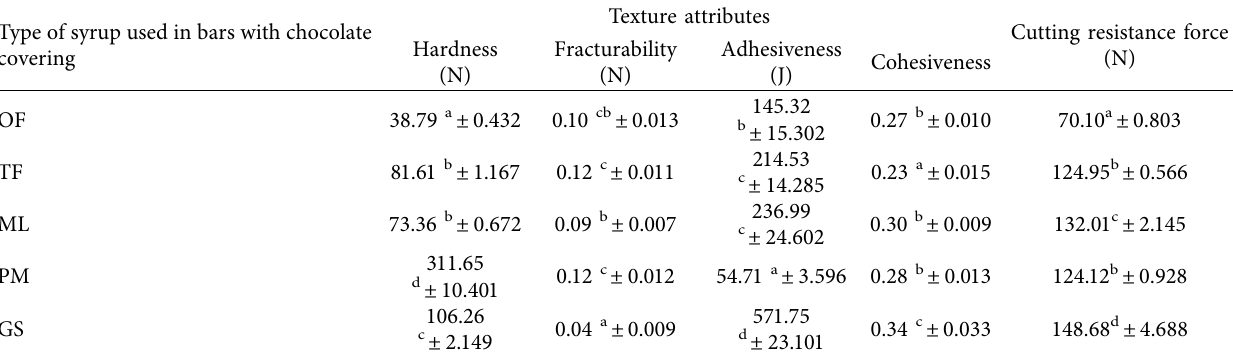
Table 2: Impact of different syrup applications on high-protein bars texture attributes and cutting resistance. Type of syrup used in bars with